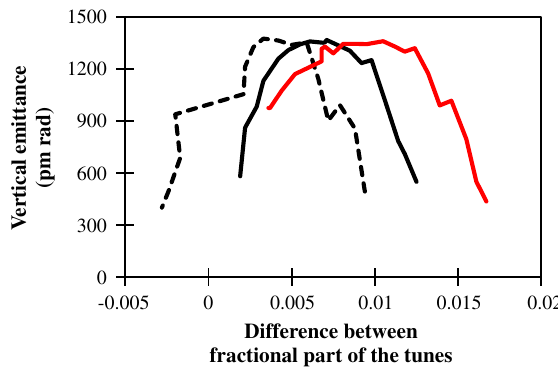
FIG. 7. Same as Fig. 6 for bunch currents: 20 (red), 12 (black) and 6 mA (black dashed).